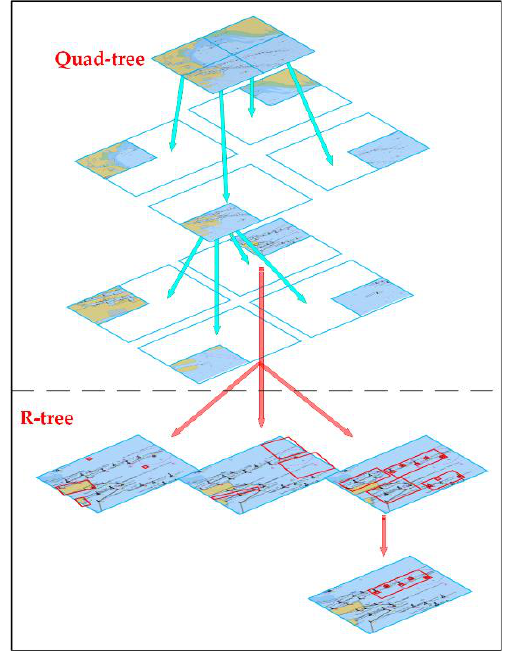
Figure 5. Spatial index structures of 3D ENC features.